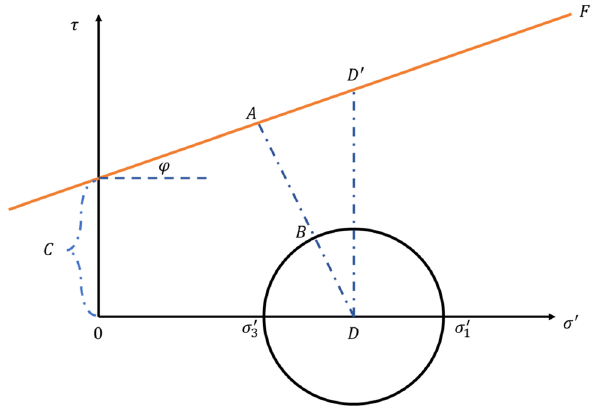
Figure 6. Mohr–Coulomb circle and failure